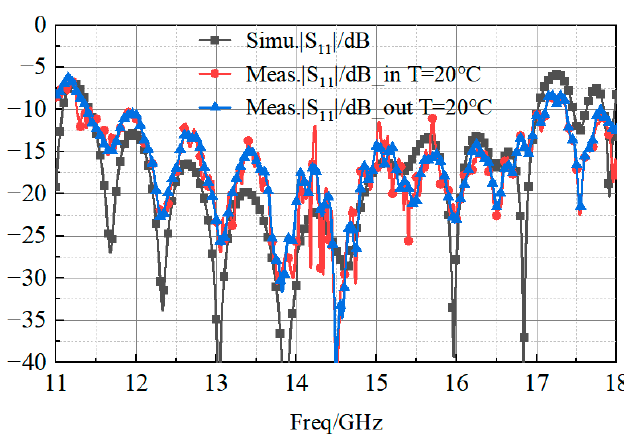
Figure 18. Measured re fl ection coe ffi cient at a temperature of 20 °C inside and outside the high–low temperature chamber.